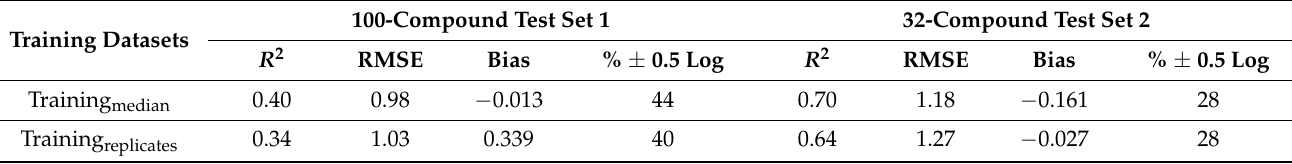
Table 7. Statistical measures of prediction performances obtained on the SC-2 test sets with ANN based on Training median and Training replicates